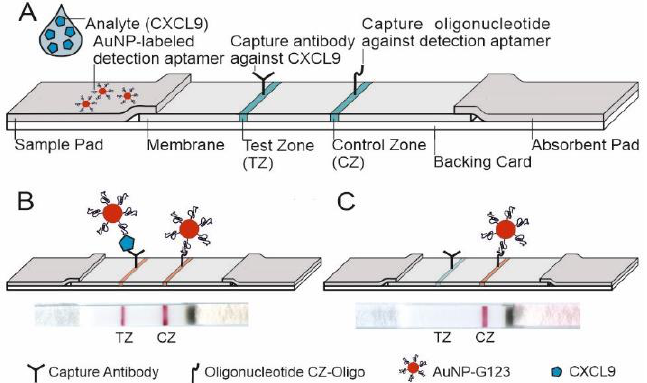
Figure 5. Schematic of the basic structure of the developed aptamer-antibody-hybrid-lateral flow assay (hybrid-LFA) with sample pad, nitrocellulose membrane and absorbent pad, providing the necessary lateral flow fluids and overlapping glued to a backing card. The hybrid-LFA uses a capture antibody in the test zone (TZ) and a detection aptamer conjugated to gold nanoparticles both with high affinity for CXCL9. ( A ) test platform composition, ( B ) positive test (two red lines, TZ and CZ), ( C ) negative test (one red line, CZ) (modified according to Seiler et al. [47]).